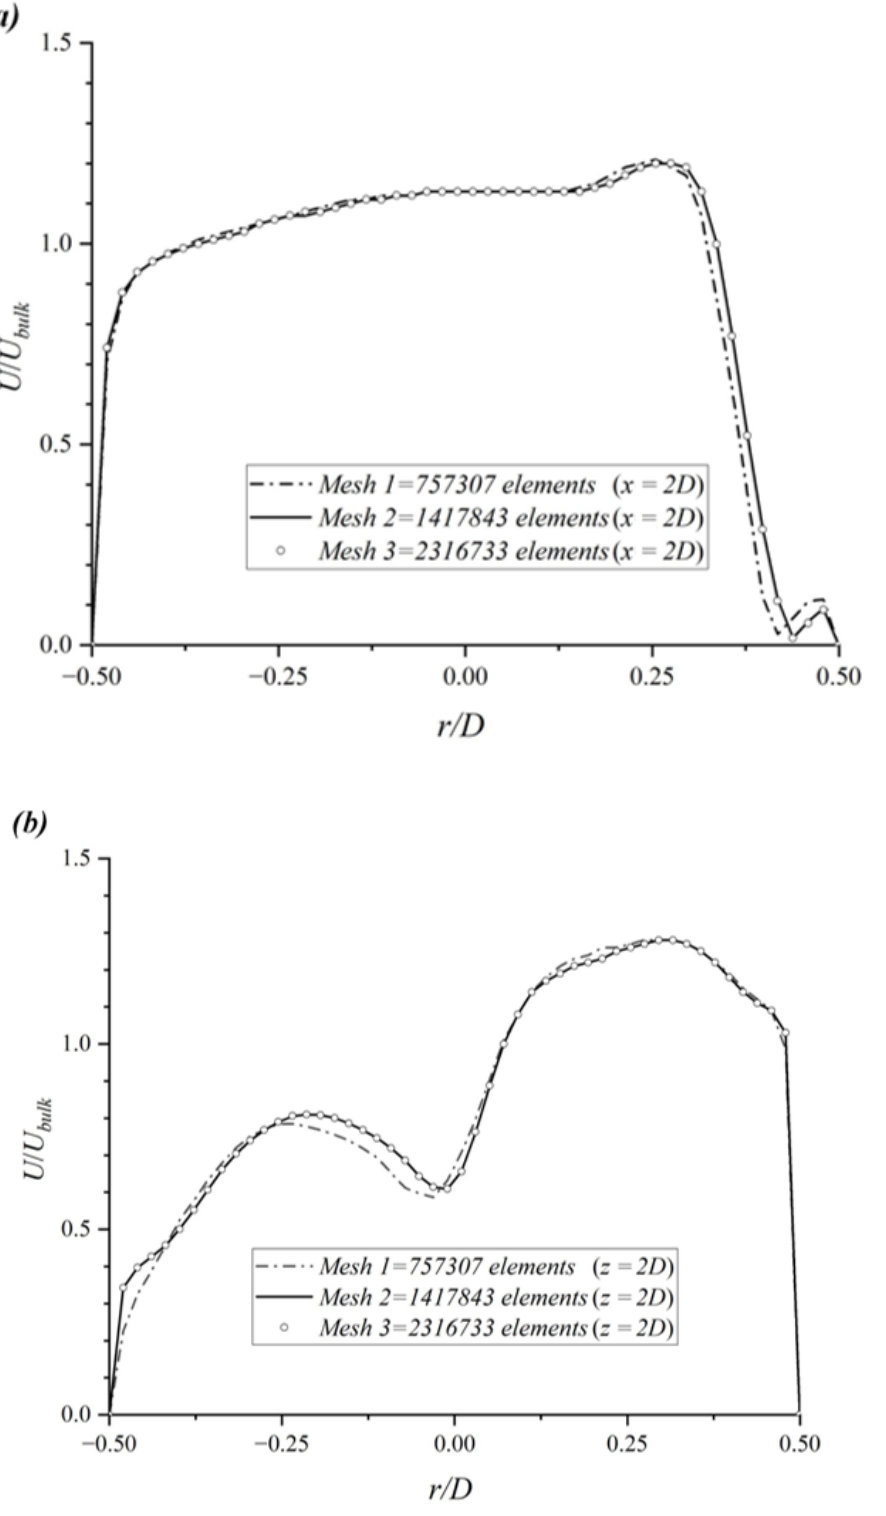
Figure 2. Velocity profiles at ( a ) outlet of upstream bend ( z = 2 D ) and ( b ) outlet of downstream bend ( x = 2 D ) for verification study.